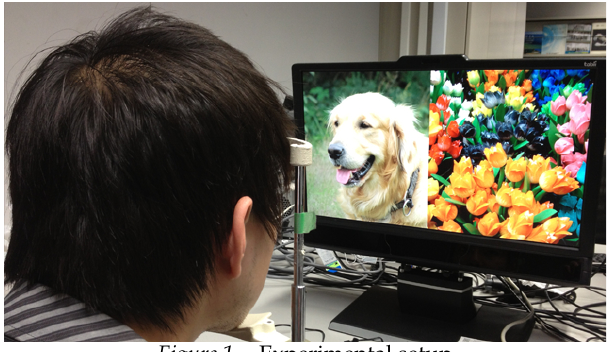
Figure 1 . Experimental